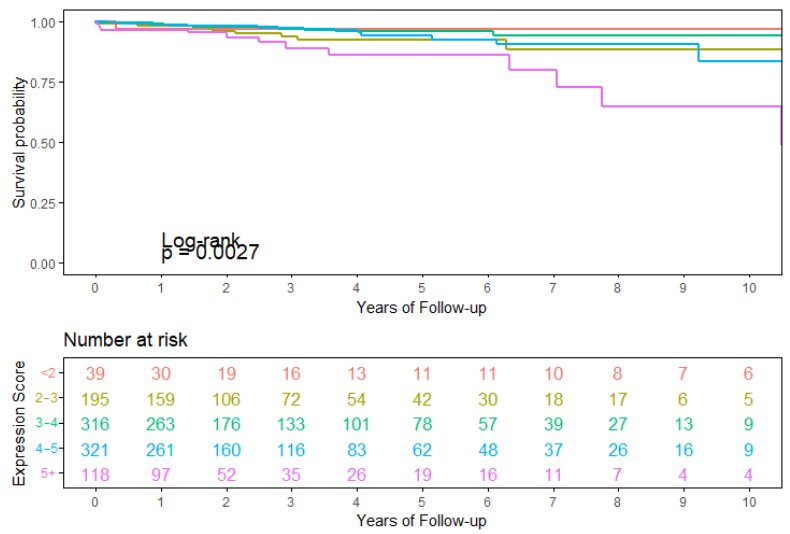
Figure 11. 10–year survival using TCGA-BRCA data and an expression score calculated across the seven genes which overlapped between the 27K with SMOTE, 450K with SMOTE, and the tumor suppressor/oncogene